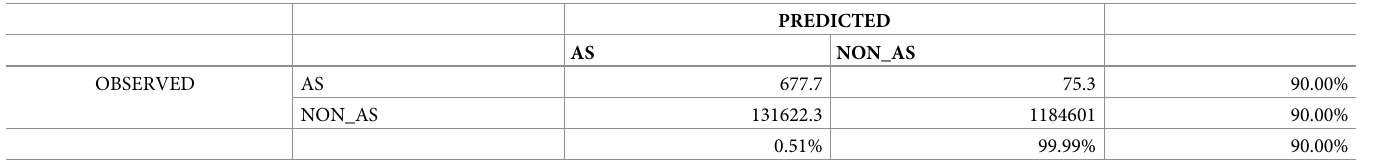
Table 8. Perfect model output